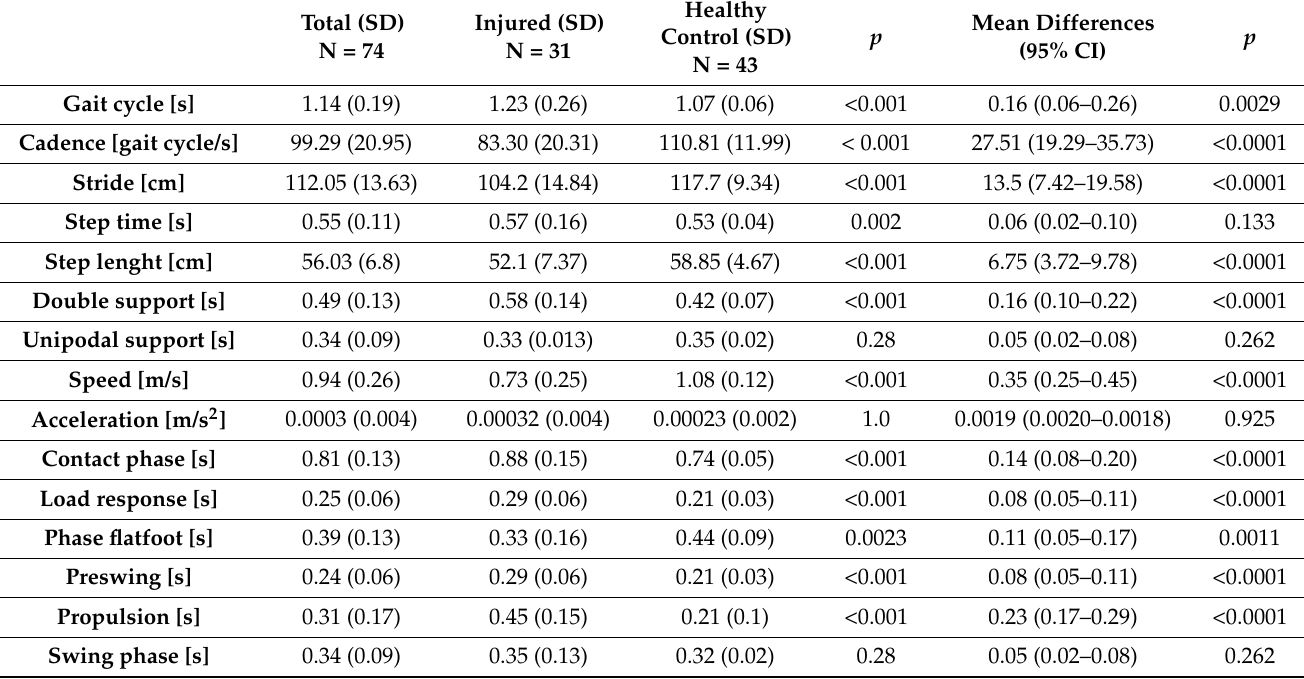
Table 2. Values of the spatio-temporal gait parameters, and mean differences between groups.